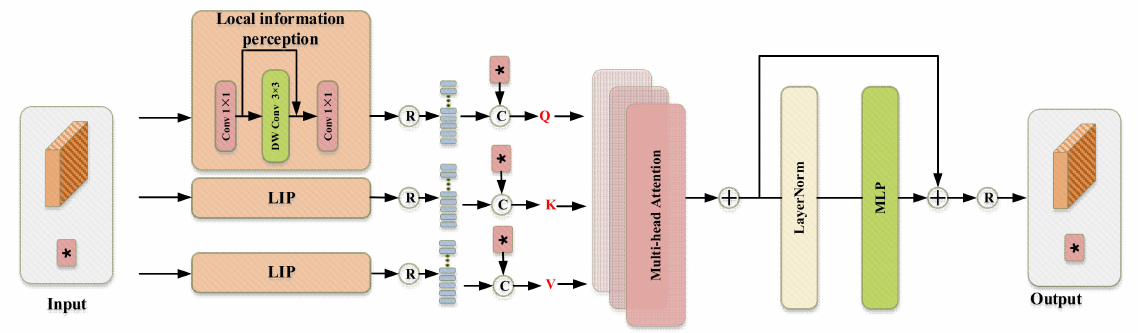
Figure 7. The architecture of the proposed Transformer